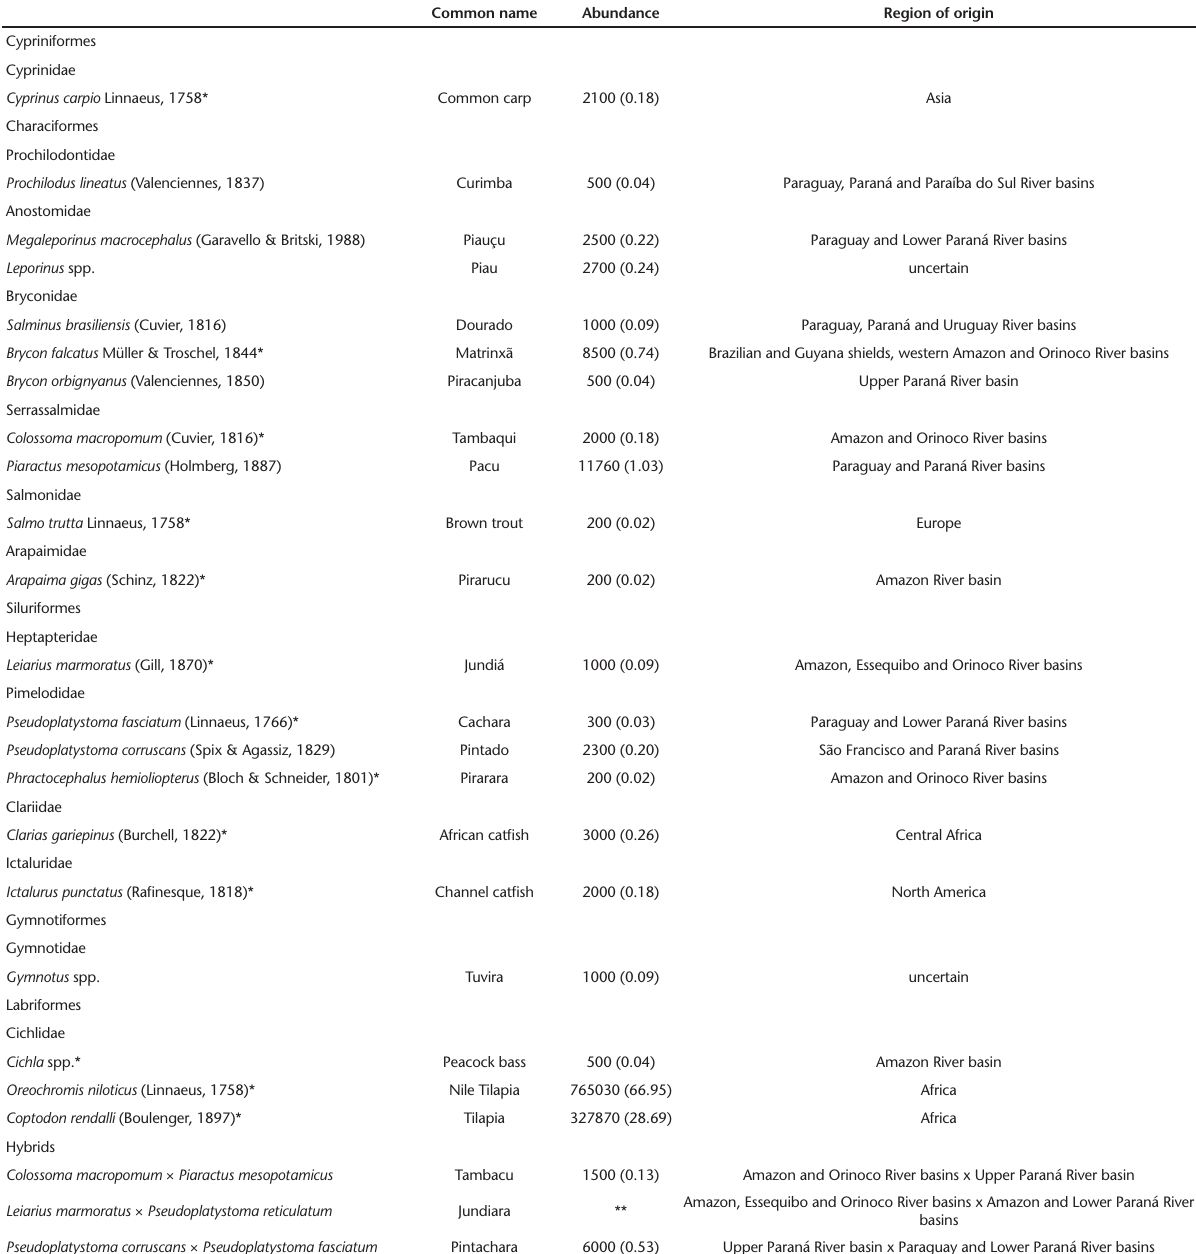
Table 1. Absolute (relative) abundance and origin of fish species and hybrids registered in the escapes from fish ponds of the Paranapanema River basin during the flood of 2015/2016. Classification and origin are based on Eschmeyer (2017). *Non-native species, **unquantified